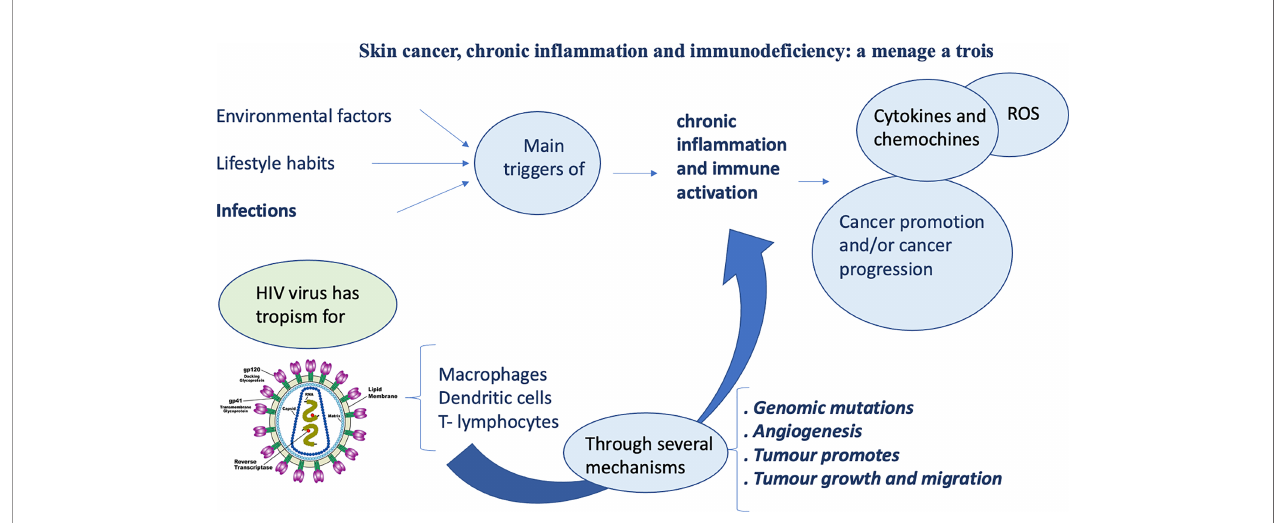
FIGURE 1 | Chronic in fl ammation and immune activation: a delicate